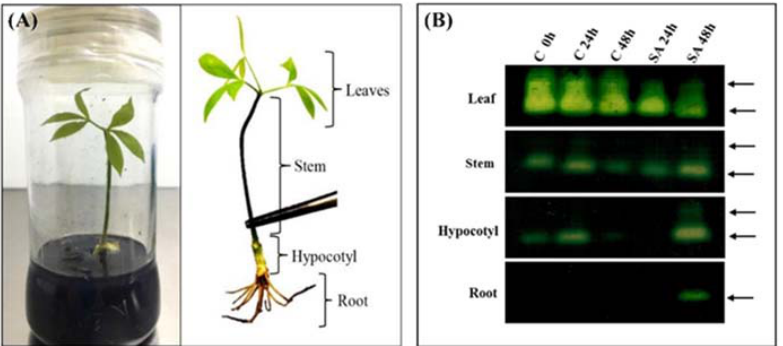
Figure 5. Effect of SA on CAT activity in different rubber tree organs. ( A ) The 45-day-old in-vitro culture of rubber tree plantlets grown in MS medium supplemented with 5 mM SA; and ( B ) The CAT activity staining after native-PAGE of crude protein from each organ (leaves, stems, hypocotyls and roots) of rubber tree plantlets treated with 5 mM SA at indicated times (0 h, 24 h and 48 h), equal volume of crude extract (5 μ L) of each rubber tree organ was loaded on native-PAGE and stained for CAT activity. Arrows indicate the position of CAT activity band.